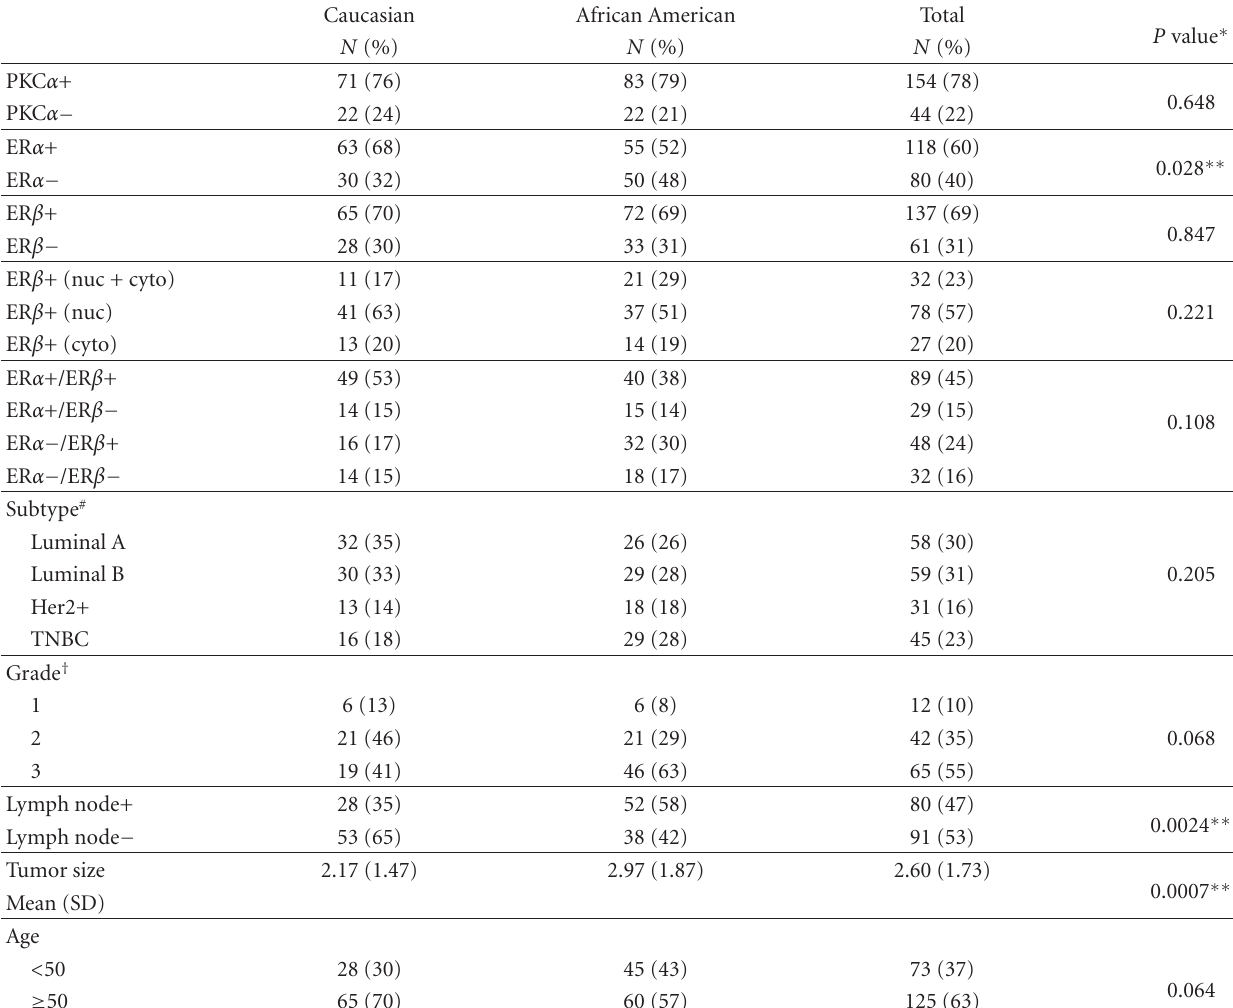
Table 1: Clinicopathological characteristics of 198 infiltrating ductal